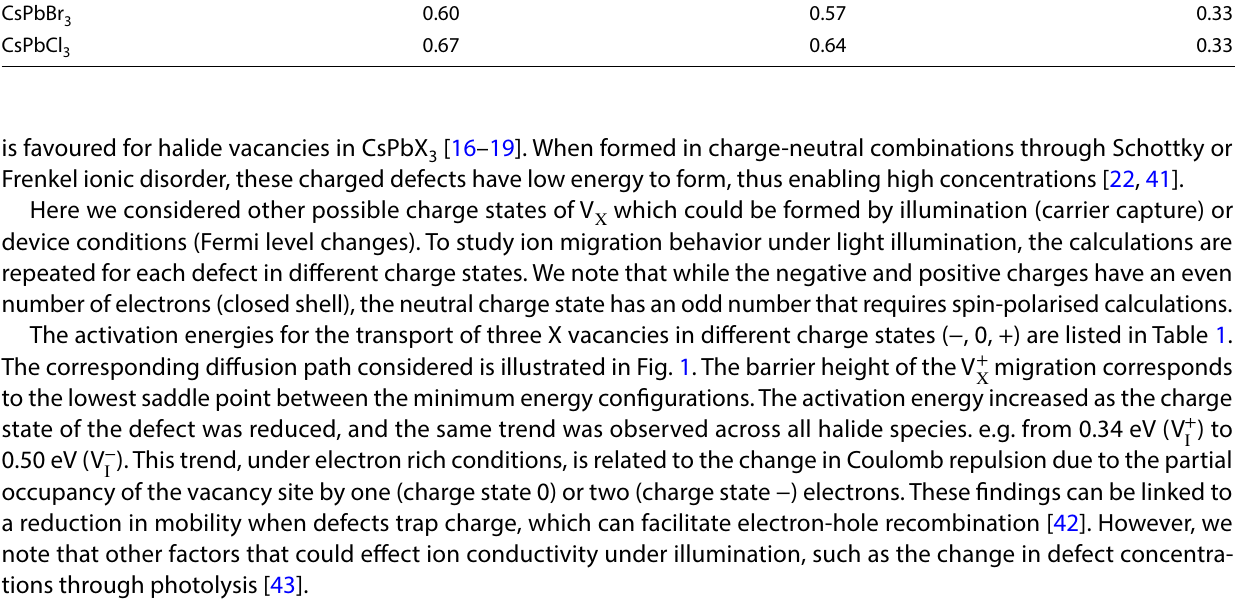
for three defect charge states. The lowest barrier is found for 3